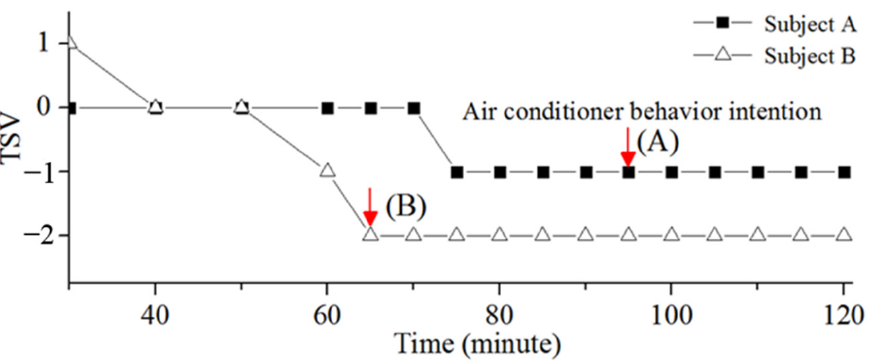
Figure 8. TSV and air conditioning off behavior intention of two typical participants in scenario D (27 → 23 °C).